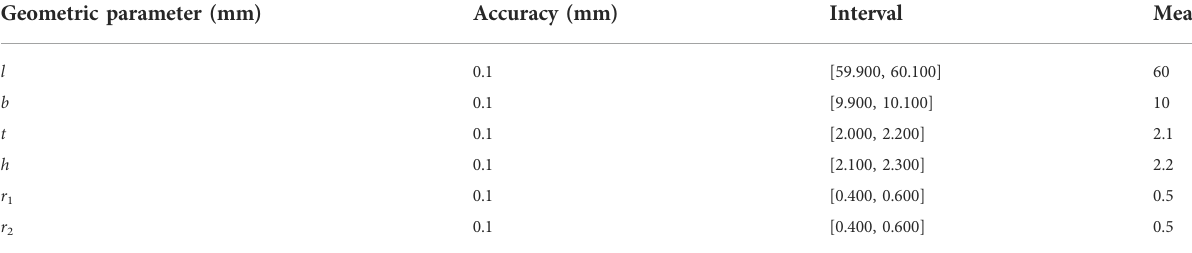
that the stiffness characteristics of the QZS microstructure with 2% uncertainty obtained by the HOSPSCPE method (upper bound: red dots and lower bound: blue pentagrams) are very